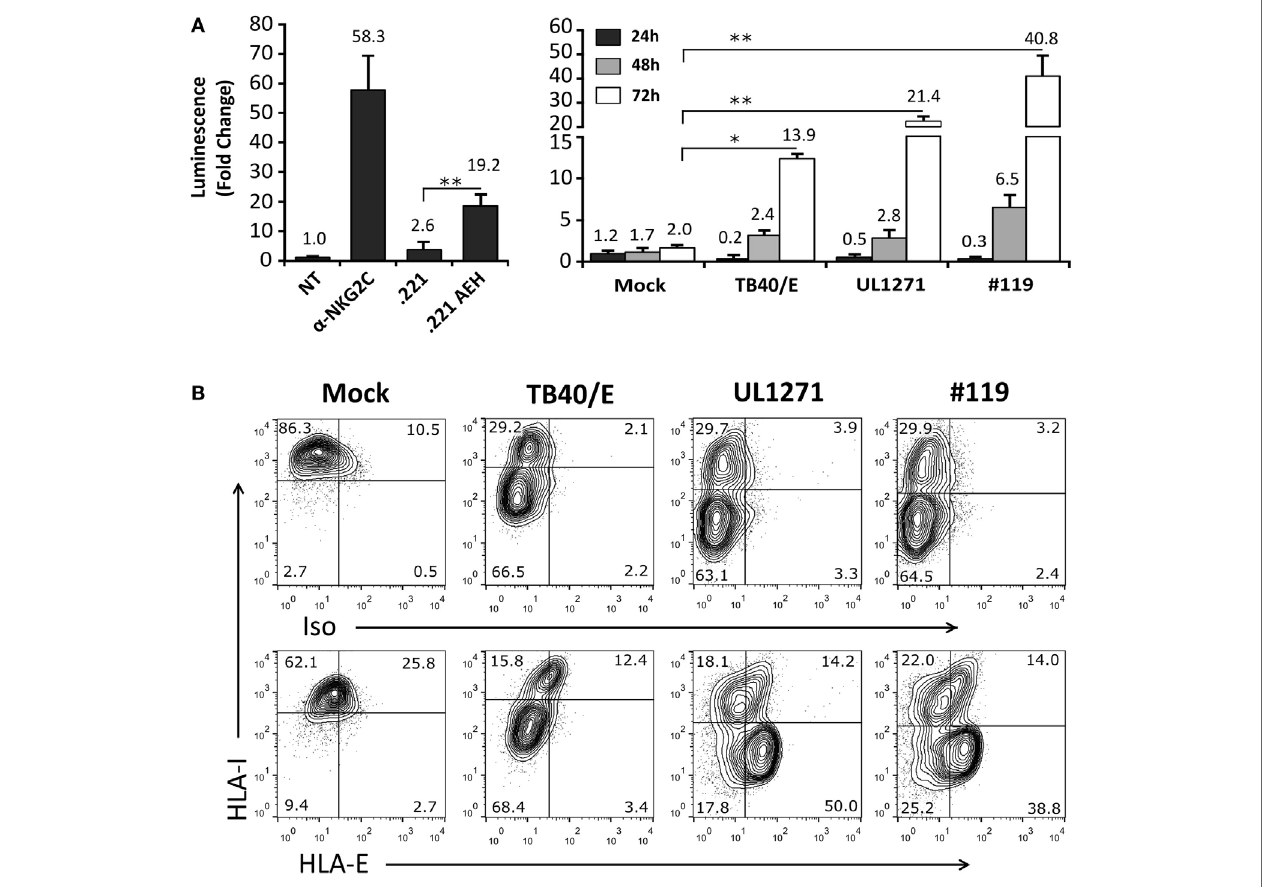
FigUre 5 | Activation of Jurkat-NKG2C + reporter cells by HFFF infected with human cytomegalovirus TB40/E or clinical isolates is independent of HLA-E expression. (a) The Jurkat-NKG2C + reporter was cocultured with HFFF cells at different time-points (24–72 h) postinfection with TB40/E or two different clinical isolates (UL1271 and #119) (multiplicity of infection = 10). Data correspond to three independent experiments (mean ± SD). Average infection rate for each experiment was > 50%. (B) Total HLA-I and HLA-E surface expression was monitored at 72 h postinfection. Statistically significant differences are indicated (* p < 0.05; ** p <